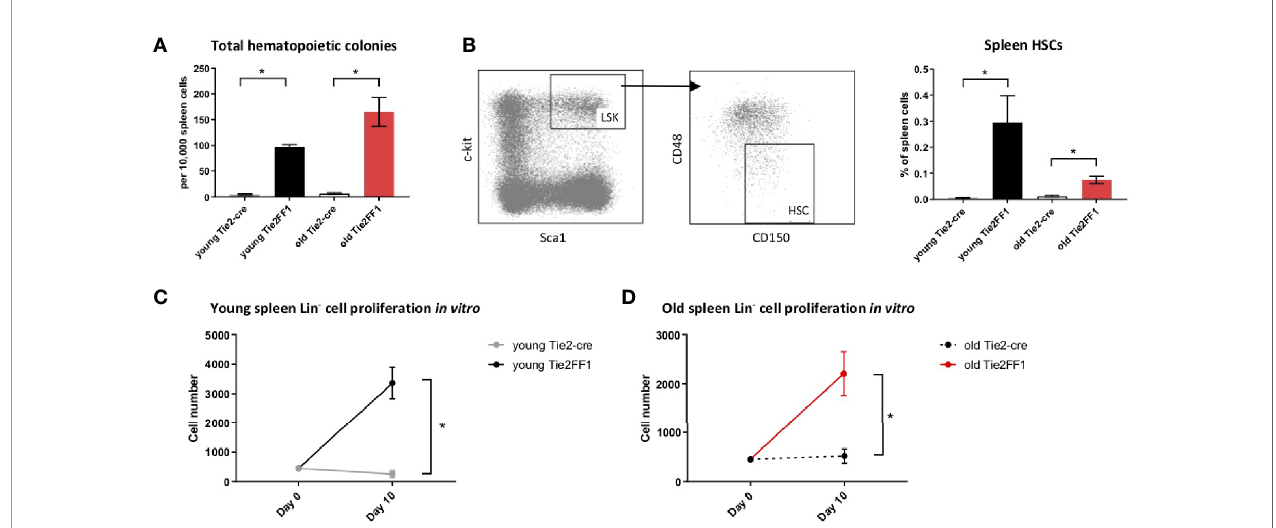
FIGURE 3 | Expanded splenic extramedullary hematopoiesis in the Tie2FF1 mice. (A) Colony formation assays in spleen cells isolated from young (n=3 mice in each group) and old (n=5-6 mice in each group) Tie2-cre control and Tie2FF1 mice. (B) Spleen Lin-cKit + Sca1 + CD150 + CD48 - HSCs frequency in young (n=3 mice in each group) and old (n=5 mice in each group) Tie2-cre control and Tie2FF1 mice. (C, D) Cell proliferation of spleen Lin HSPCs isolated from young (C) and old (D) Tie2- cre control and Tie2FF1 mice. Cells were cultured in SFEM medium containing recombinant mouse SCF (1OOng/mL), recombinant mouse IL3 (6ng/mL), and recombinant human IL6 (1Ong/mL). Data are from one of two independent experiments (with triplicates in each experiment) that gave similar results. *P <